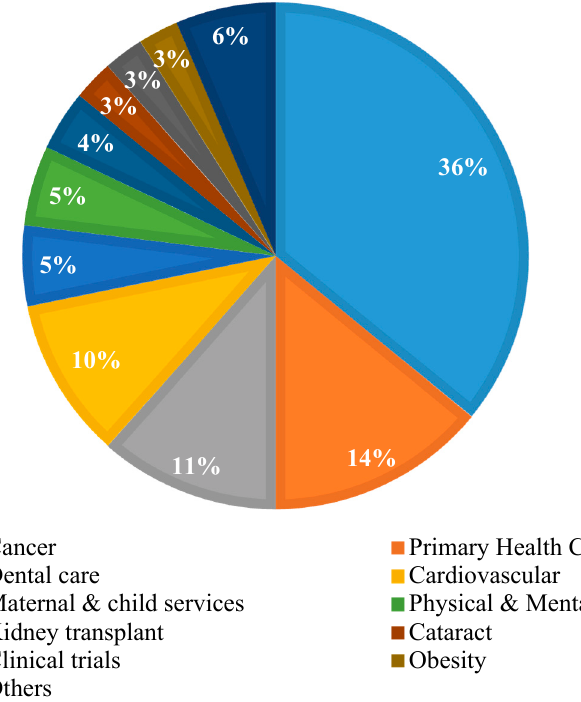
Figure 5. Percentage of studies conducted for various disease types (others include diabetes, disability, frailty, hepatitis C and strokes, each contributing equally).